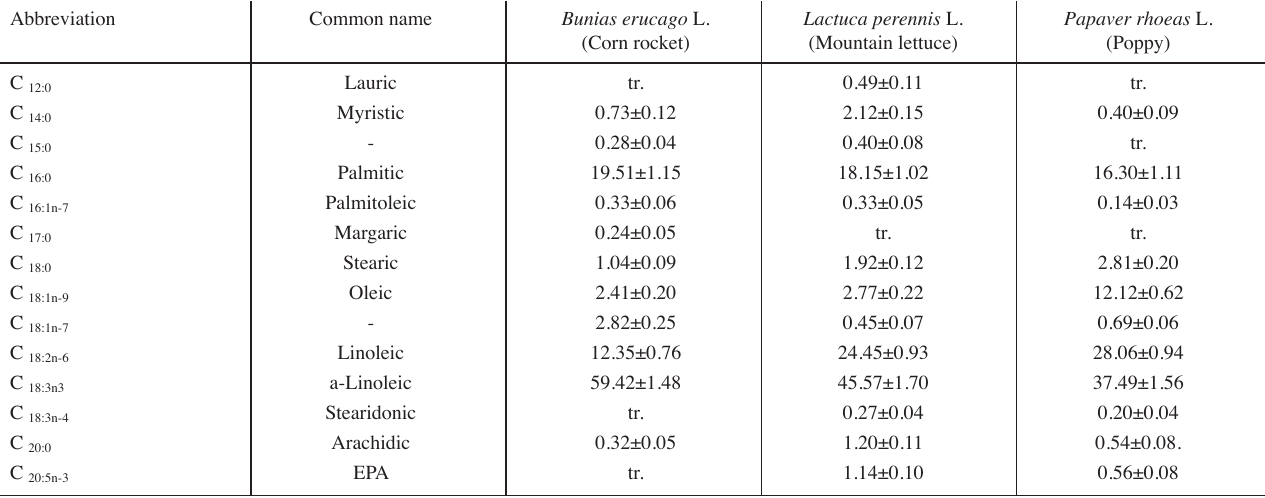
Tab. 2: Most representative fatty acids of the raw edible wild plants (%of total fatty acids).